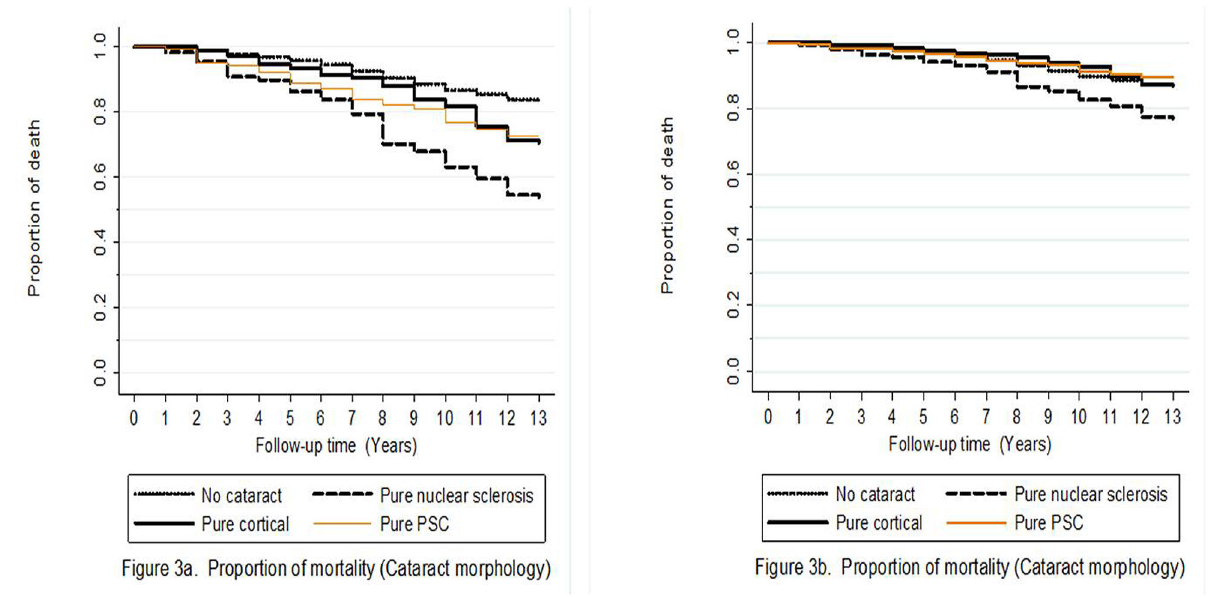
Figure 3. Survival curves for cataract morphology and mortality: a) Unadjusted and b) Adjusted for age and gender.